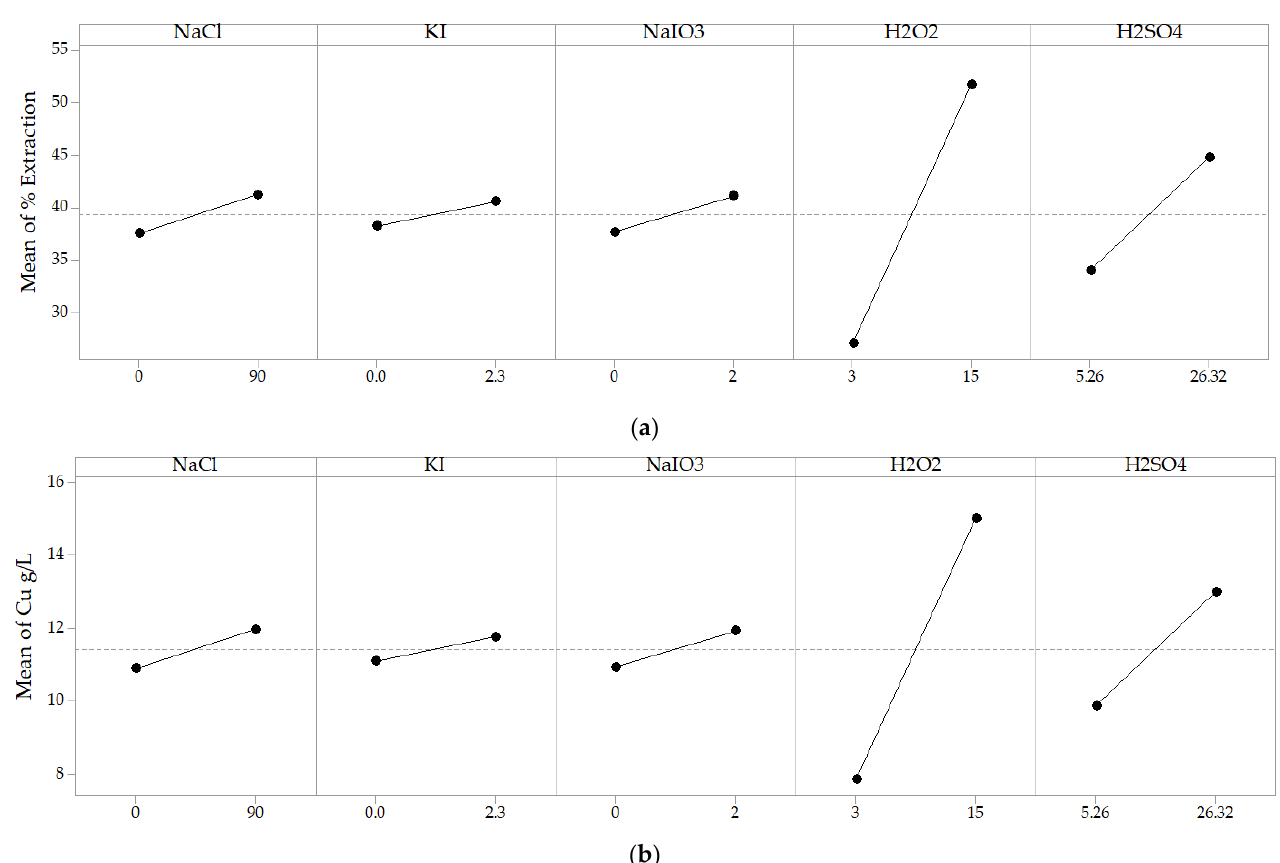
Figure 3. Main effect plots . ( a ) Main effects on % Extraction as response. ( b ) Main effects on Cu concentration in PLS.